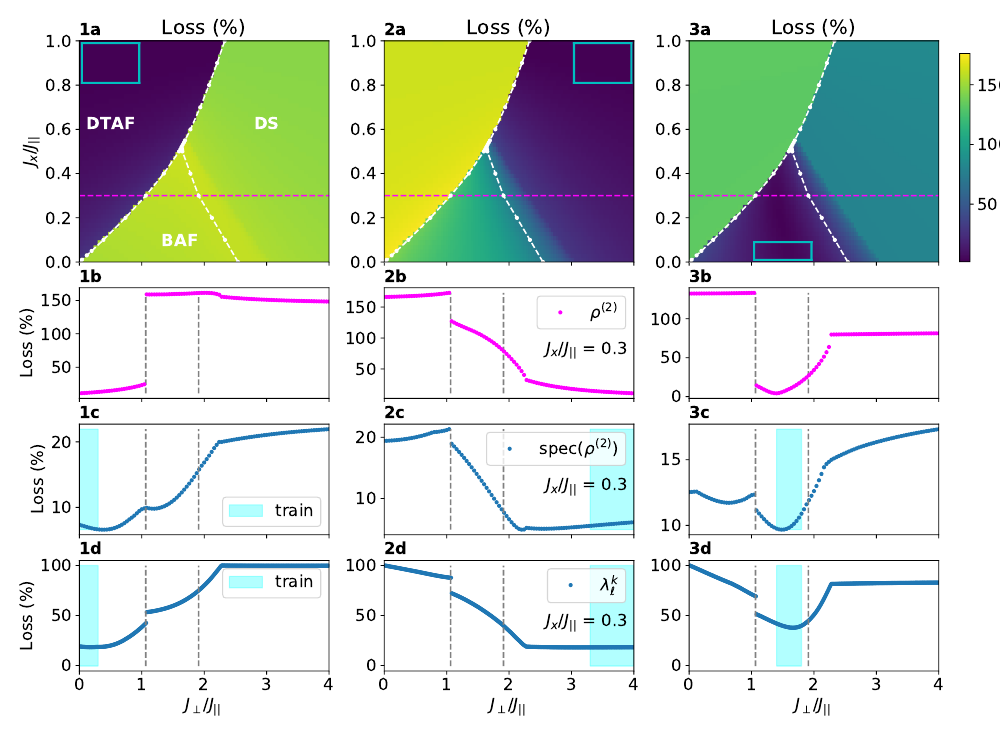
Figure 2: Three training iterations to map out all three phases of the phase diagram. Here, the reduced 2-site density matrix is used as input data. In comparison to fig. 1, the first order transition line is much sharper as the ground states were post-selected from energy considerations. The second row (b) shows the line at J ⊥ / J || = 0.3 as indicated by the dotted magenta line in row (a). In row (c), the eigenvalues of the reduced 2-site density matrix in log-scale are used. The training is done just for the single cut at J ⊥ / J || = 0.3. Row (d) uses again the singular values like in fig.